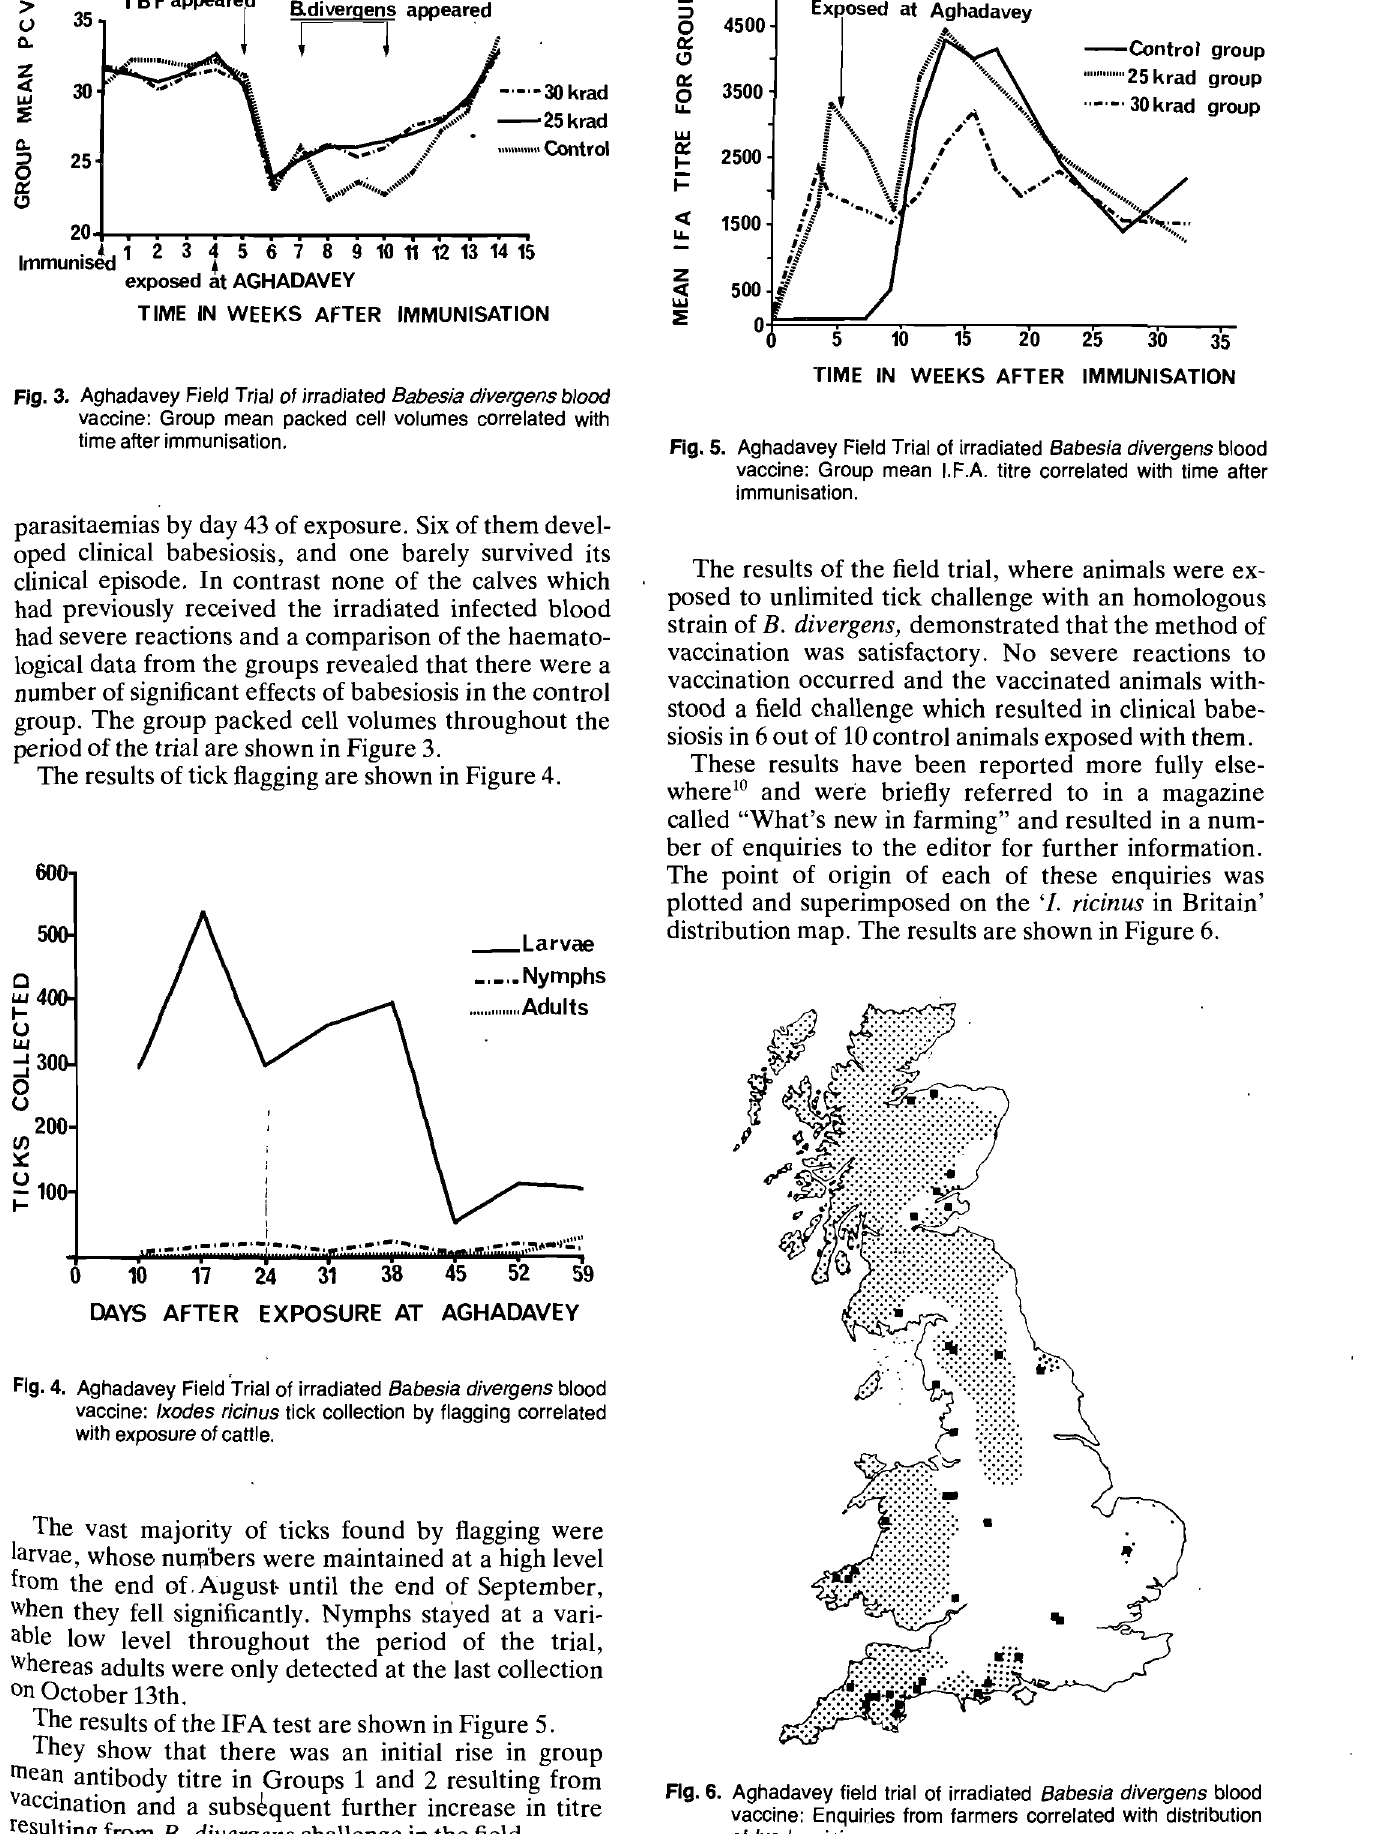
Fig. 6. Aghadavey field trial of irradiated Babesia diverg~n~ blood vaccine: Enquiries from farmers correlated with distribution of Ixodes